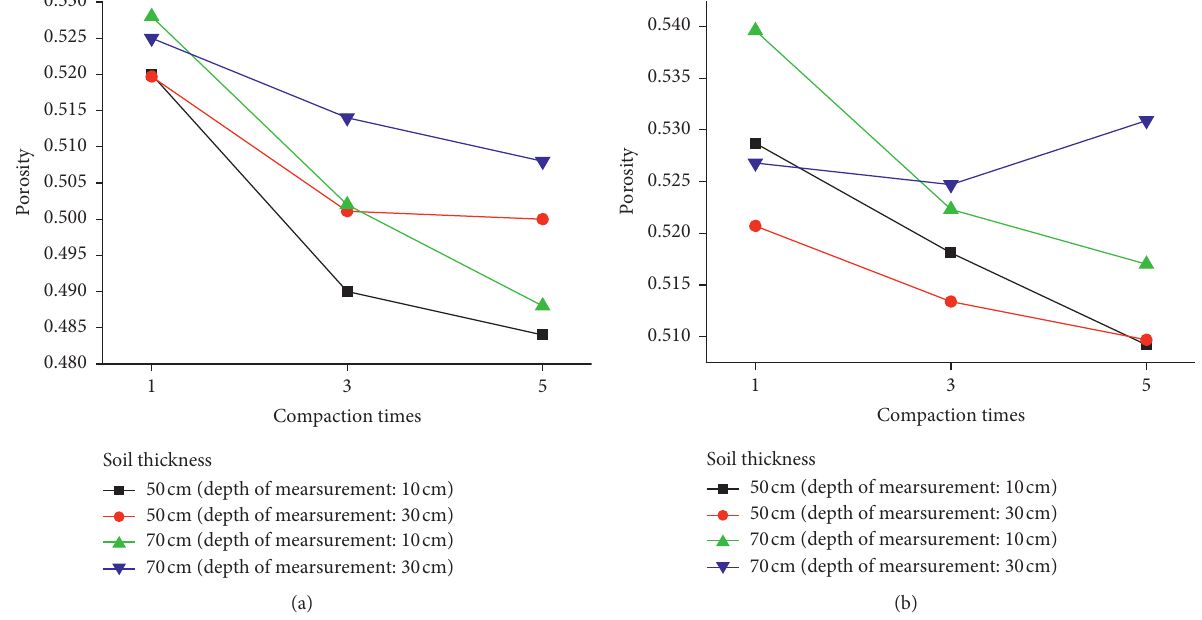
Figure 28: Curves of porosity of different thicknesses of soil and different depths with different compaction times: the results of (a) numerical simulation and (b) physical simulation.